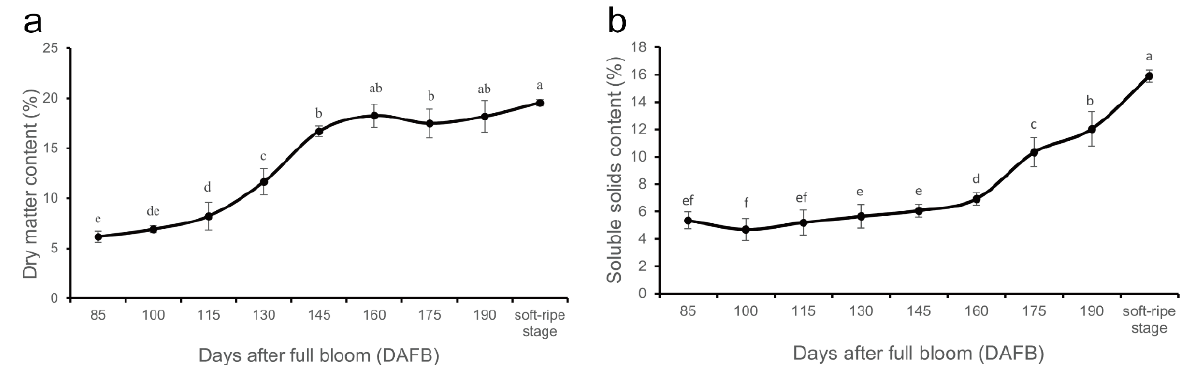
Figure 1. Dynamic changes of dry matter content and soluble solid content during fruit development of A. eriantha ‘Ganlv 1’. ( a ) Changes of dry matter content during fruit development of ‘Ganlv 1’; ( b ) Changes of soluble solid content during fruit development of ‘Ganlv 1’.